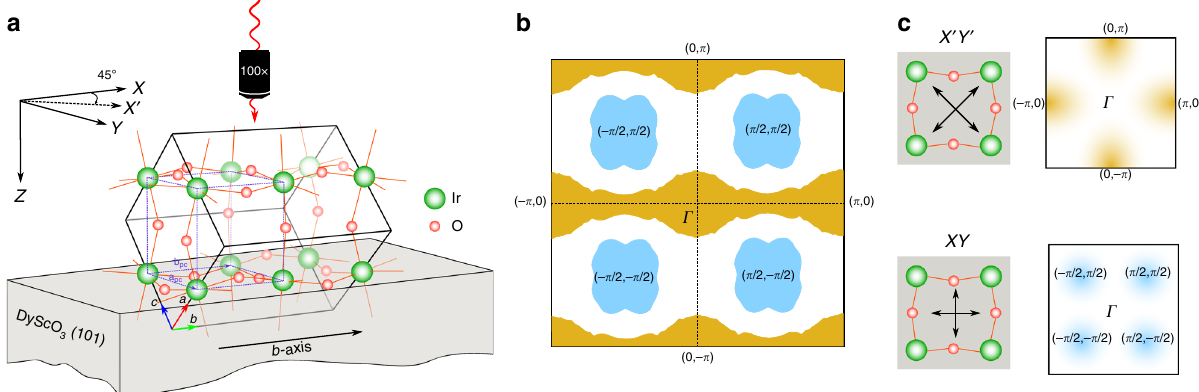
Fig. 1 Polarization selection rules. a Sketch illustrating orientation of SrIrO 3 crystal unit cell of Pnma space group on (101)-DyScO 3 substrate. A pseudocubic unit cell of SrIrO 3 is designated by blue dashed lines. The XYZ -coordinate system concerning the backscattering Raman experiments is marked in black arrows. Incoming laser propagates along Z -axis, as shown by a red wavy-arrow through a microscope objective. b Calculated Fermi surface is shown in 1-Ir (pseudocubic unit cell) Brillouin zone (BZ) for the respective pseudocubic unit cell. The electron pockets are at (± π /2, ± π /2), whereas the rest arises from hole-like bands. Note that the hole pocket at the Γ -point and at the 1-Ir BZ boundary at (± π , 0) are equivalent. c Electronic Raman scattering structure factors are shown on 1-Ir BZ (right panels) for the respective scattering con fi gurations, namely Z ð X 0 Y 0 Þ (cid:1) Z and Z ð XY Þ (cid:1) Z , as depicted in left panels. The corresponding symmetries are E g and T 2 g according to the point group of O h , respectively.